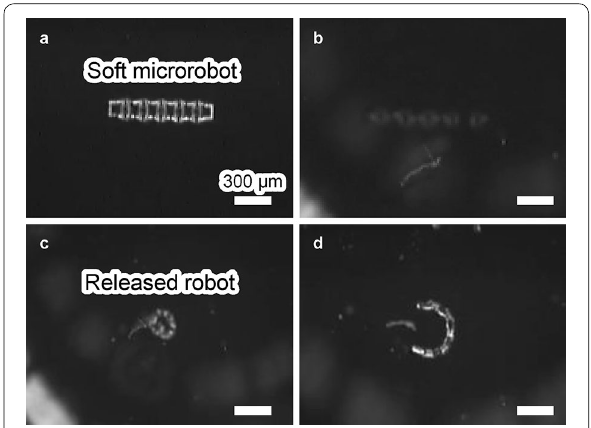
Fig. 7 Sacrificial process for release of soft microrobot. a Before immersion in water, b immediately after immersion in water, and c 20 s and d 40 s after immersion